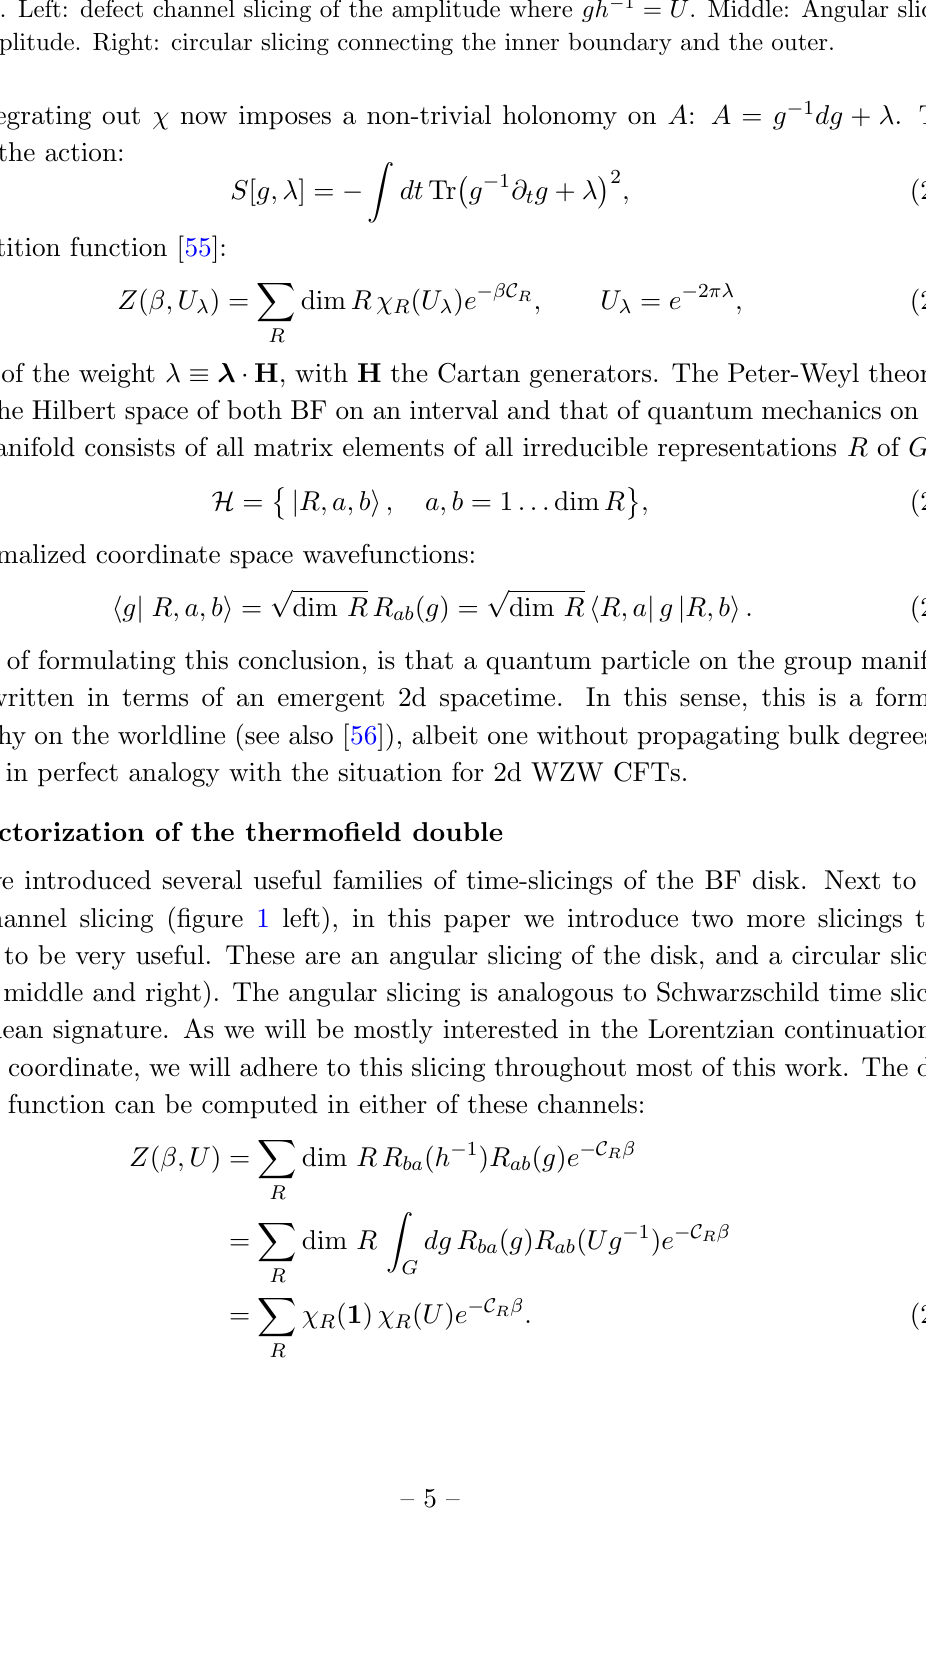
1 = U . Middle: Angular slicing −